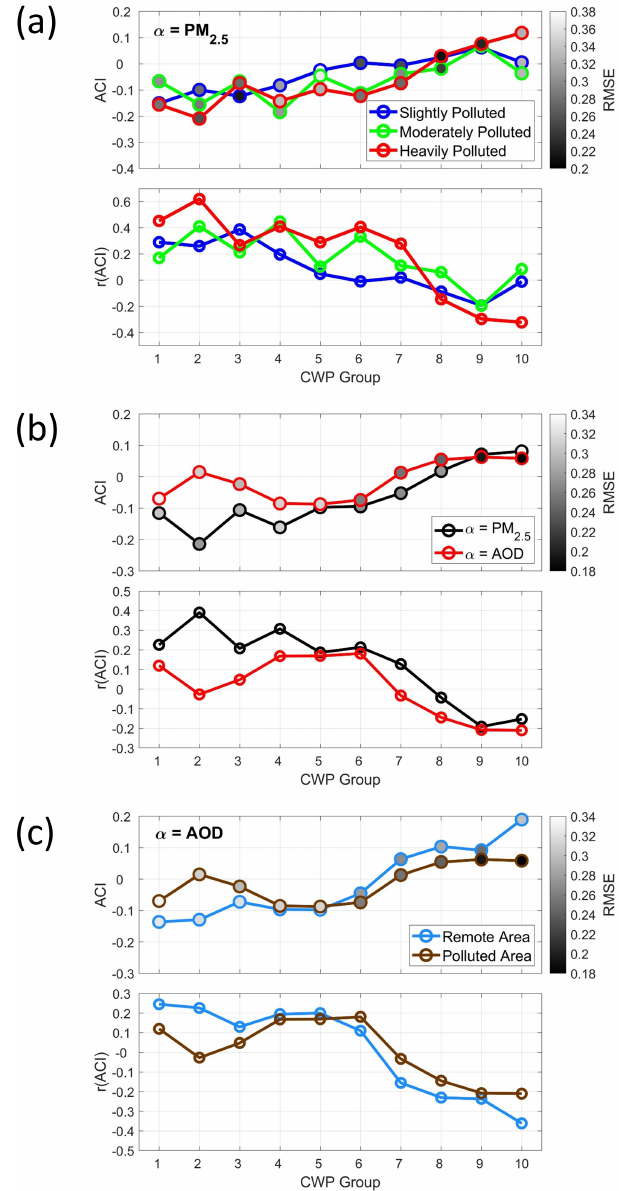
Figure 9. Multiyear (2005–2017) ACI values with the RMSE (shaded) and the correlation coefficient among (a) different polluted levels, (b) different aerosol proxies, and (c) different polluted con- dition